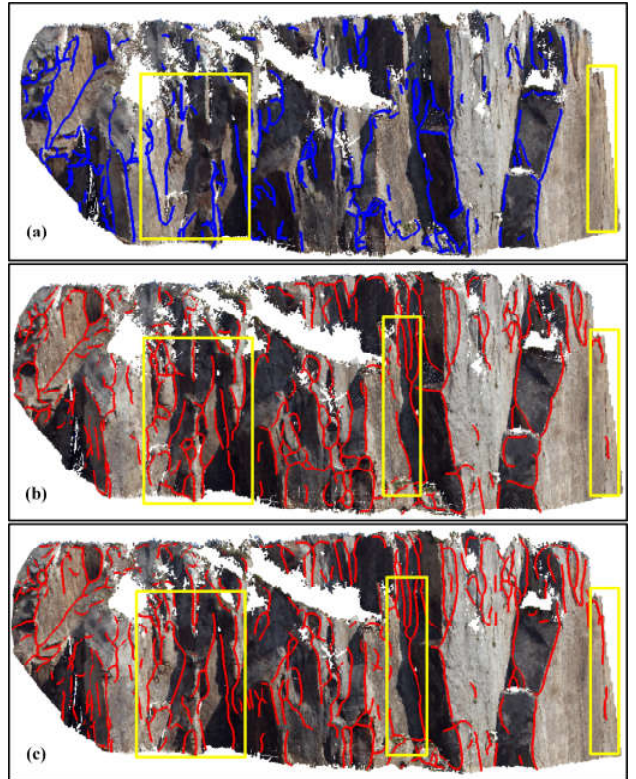
Figure 19. Case B: Comparison of the proposed method and existing methods. ( a ) The discontinuity traces extracted using tensor voting; ( b ) the result of fusing color and the geometric attributes; ( c ) the result of removing shadows by determining the light and shadow and the MS-LBP constraint.